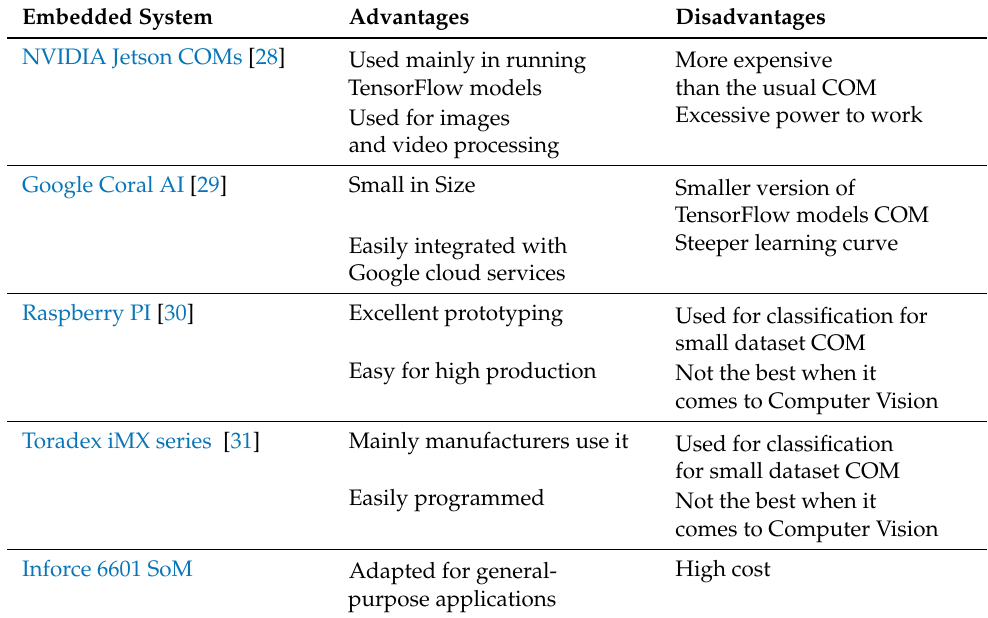
Table 2. Different Embedded Systems used in Computer Vision. Embedded